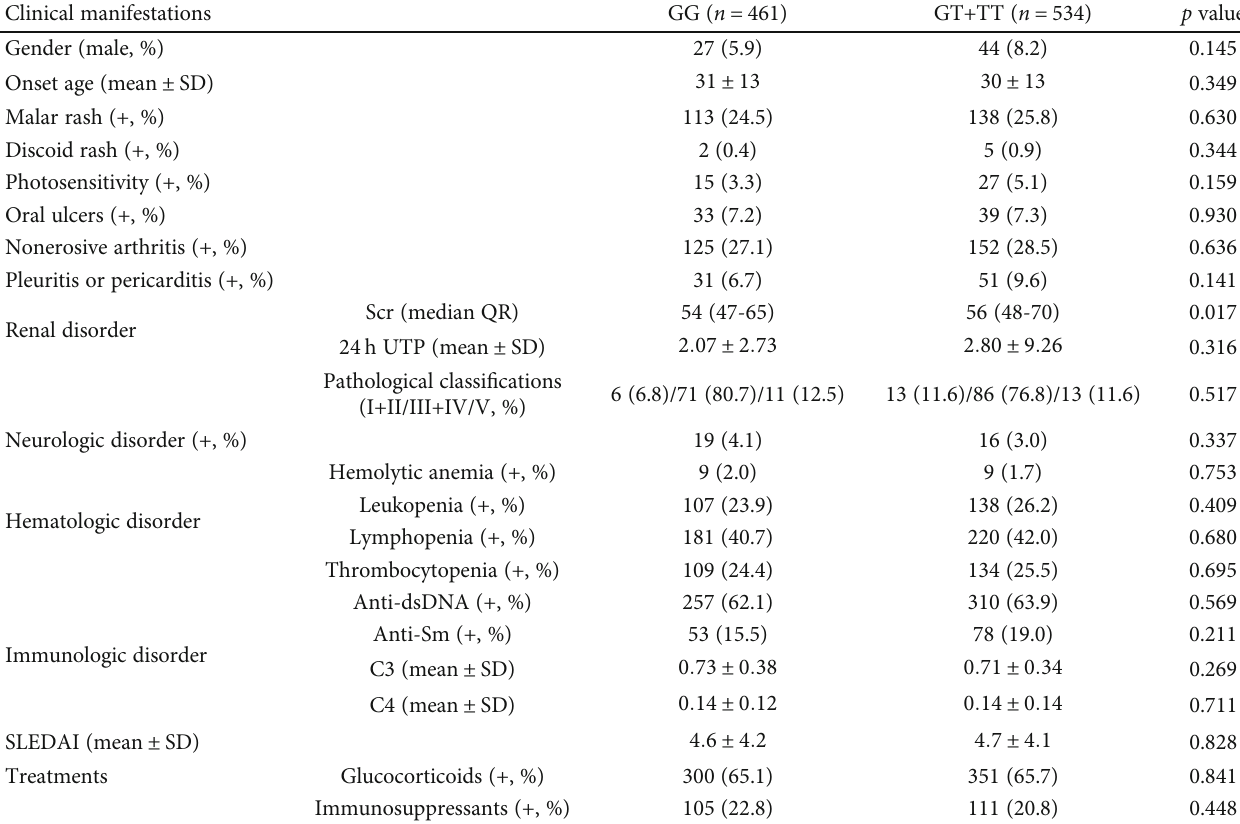
Table 3: Correlation between rs1888822 and clinical